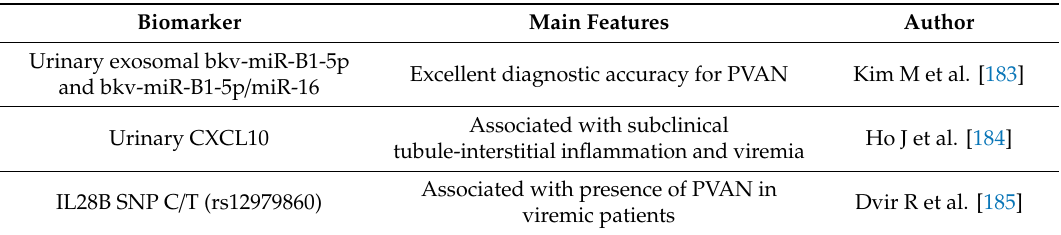
Table 10. Potential biomarkers for Polyomavirus-associated nephropathy